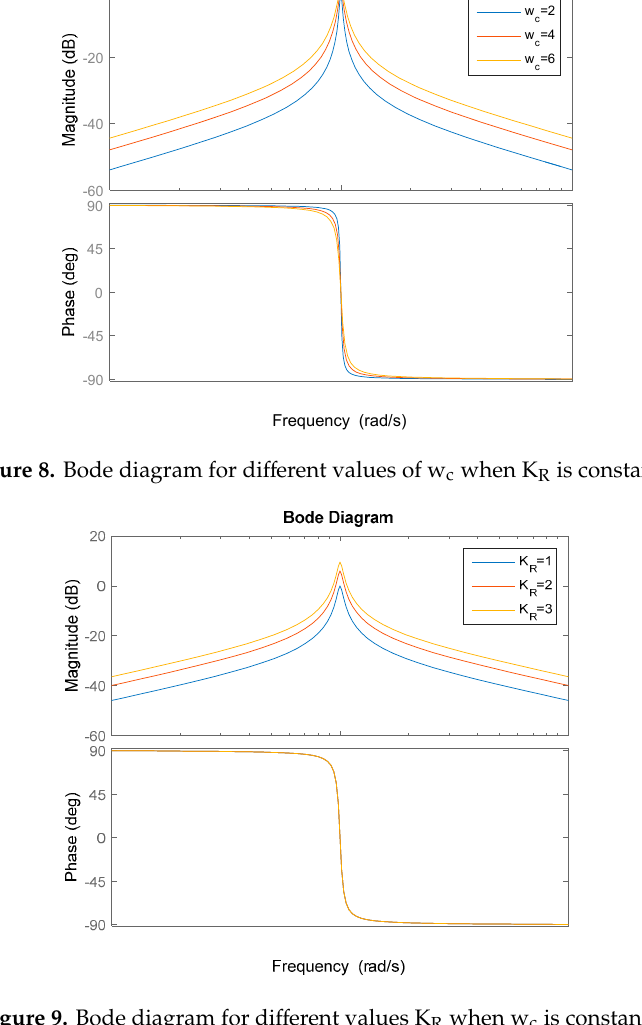
Figure 9. Bode diagram for different values K R when w c is constant.